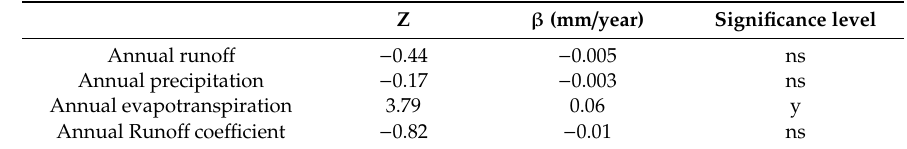
Table 2. Statistics of Mann-Kendall trend test with Sen’s slope analysis for annual runo ff and precipitation data.